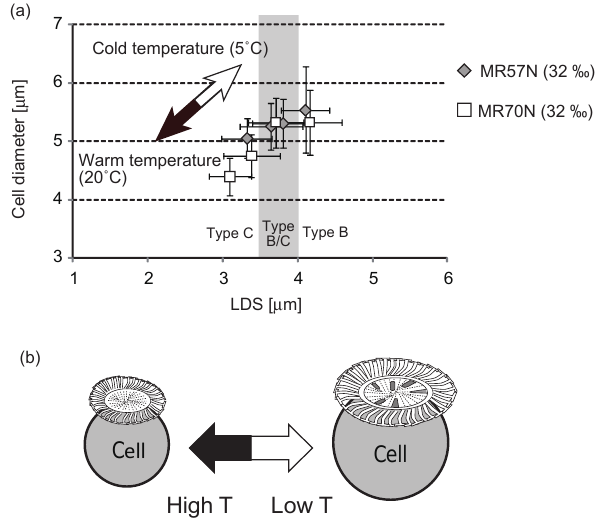
Figure 3. (a) Changes in cell diameters and LDS in E. hux- leyi strains MR57N and MR70N grown at 5, 10, 15, and 20 ◦ C; (b) schematic models of images of cell and coccolith sizes accord- ing to growth temperature. Descriptions of Type B, B/C, and C in- dicate the LDS range of coccoliths of the morphotypes defined by Young et al. (2003) and Hagino et al. (2011).